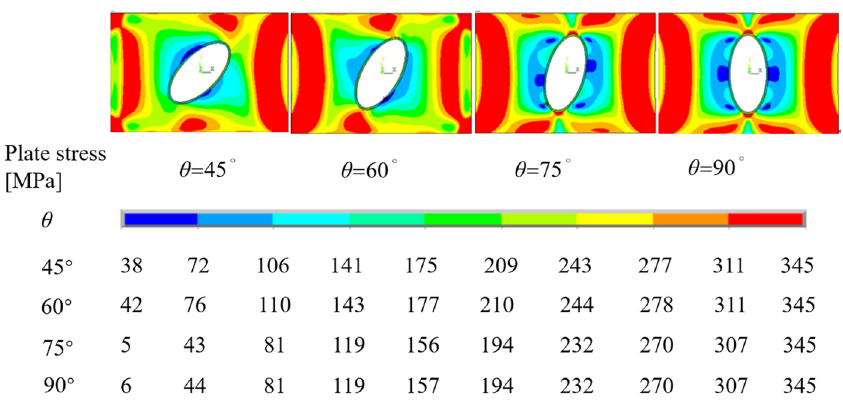
Figure 10: Stress distribution of the fl anged perforated plates with t = 2 mm in the ultimate state.